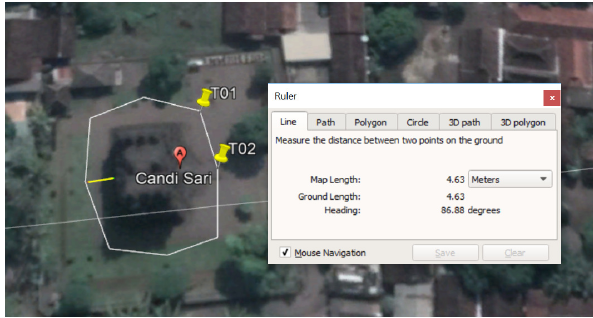
Figure 3. Preliminary planning using GoogleEarth.